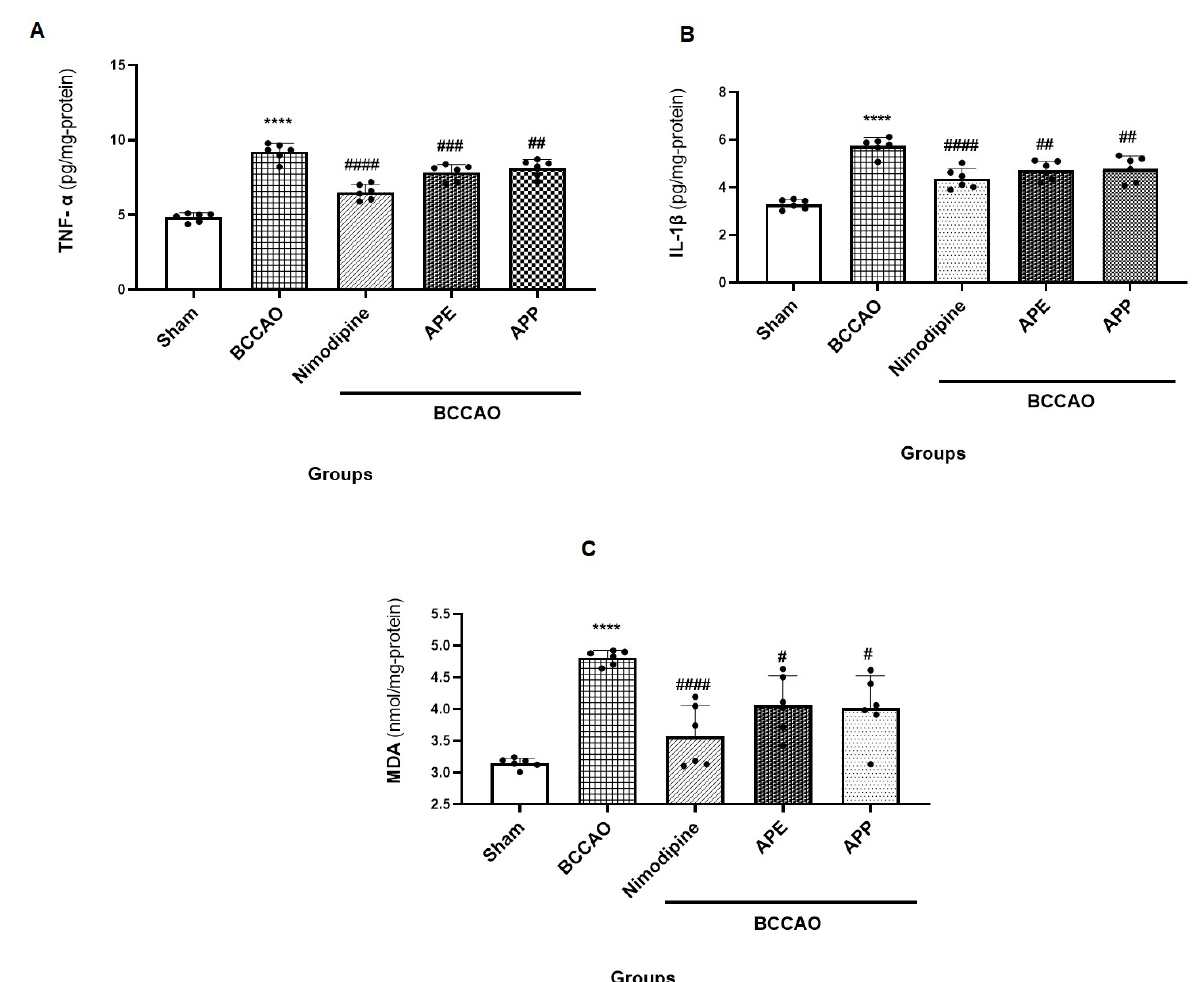
Figure 5. ( A ) The brain levels of TNF-α in experimental groups 60 min after ischemia/reperfusion. Results are mean ± SD. ( n = 6). **** p < 0.0001 vs. the sham group, #### p < 0.0001, ### p <0.001 and ## p < 0.01 vs. the BCCAO group. ( B ) The brain levels of IL-1β in experimental groups 60 min after ischemia/reperfusion. Results are mean ± SD. **** p < 0.0001 vs. the sham group, #### p < 0.0001 and ## p < 0.01 vs. the BCCAO group. ( C ) The brain levels of malondialdehyde (MDA) in experimental groups 60 min after ischemia/reperfusion. Results are mean ± SD. Repeated measures one-way analysis of variance with Bonferroni post-hoc was used. **** p < 0.0001 vs. the sham group, #### p < 0.0001 and # p < 0.05 vs. the BCCAO group.